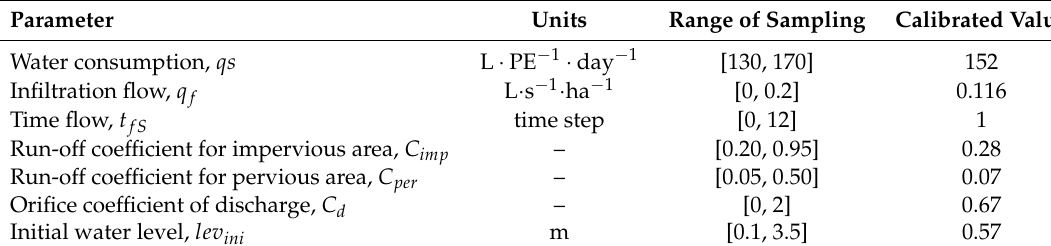
Table 3. Calibration and validation results of the hydraulic model in EmiStatR as calibrated with the DREAM algorithm (Goesdorf 2011, 10 min time